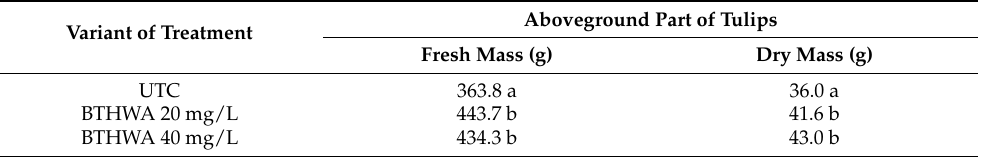
Table 5. Influence of tested variants of treatment on the fresh and dry mass of the aboveground part of tulips. Variant of